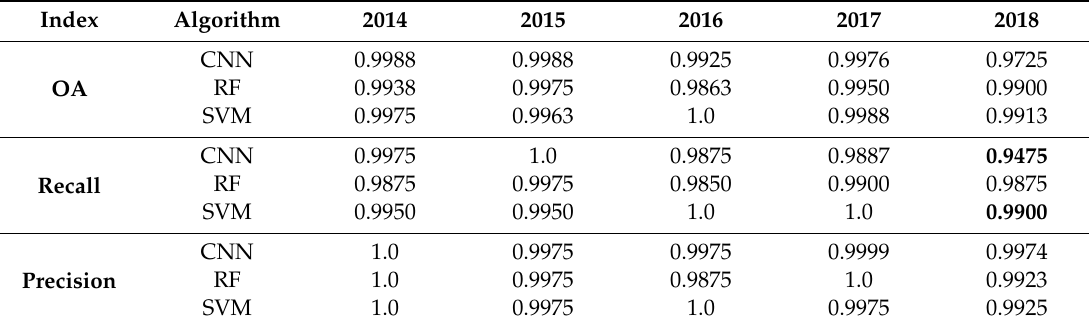
Table 6. Comparison of water identification accuracy among CNN, RF, and SVM.